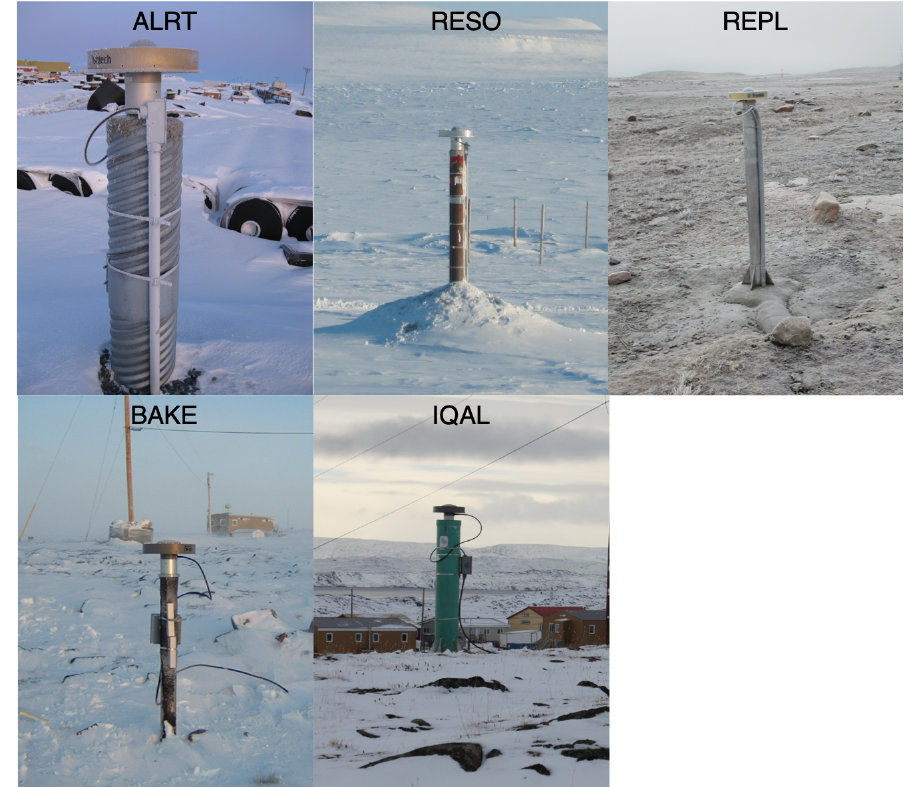
Figure 4. Ground photos of the identified CACS GPS stations. Source: https://webapp.geod.nrcan.gc.ca/geod/data-donnees/cacs-scca.php? locale=_en.